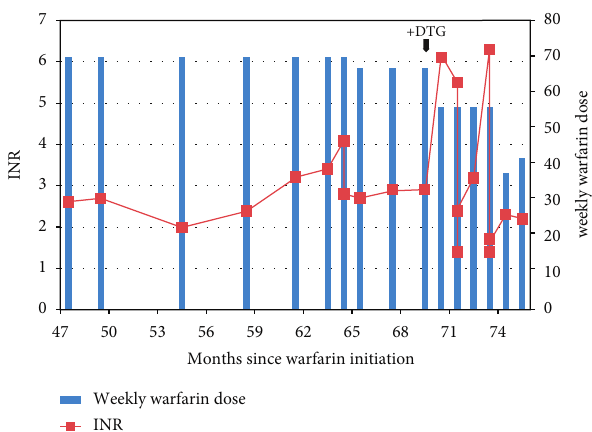
Figure 1: Graphical representation of case 1’s INR and corre- sponding weekly warfarin dose during clinical